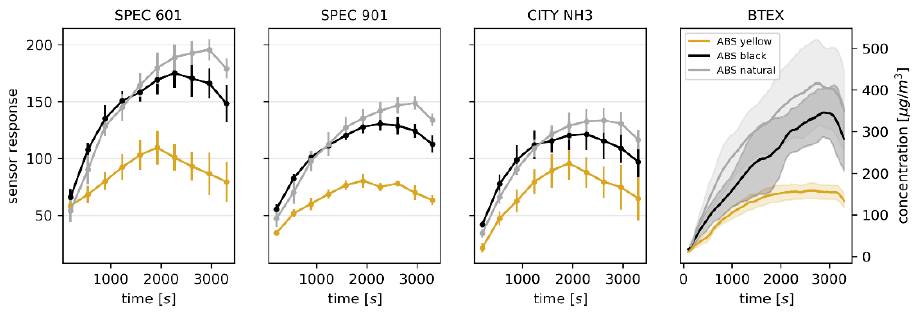
Figure 4. Average response signals of selected electrochemical sensors of the electronic nose to changes in the composition of the atmosphere within a 3D printer enclosure during printing with three different ABS filaments, and the corresponding BTEX concentration determined using PTR-MS. The error bars and the shaded areas correspond to ± SD.